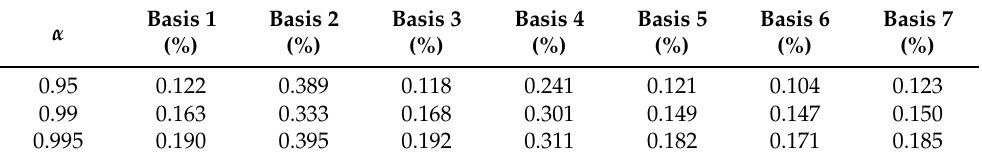
Table 6. The rRMSE of estimated VaR in Portfolio